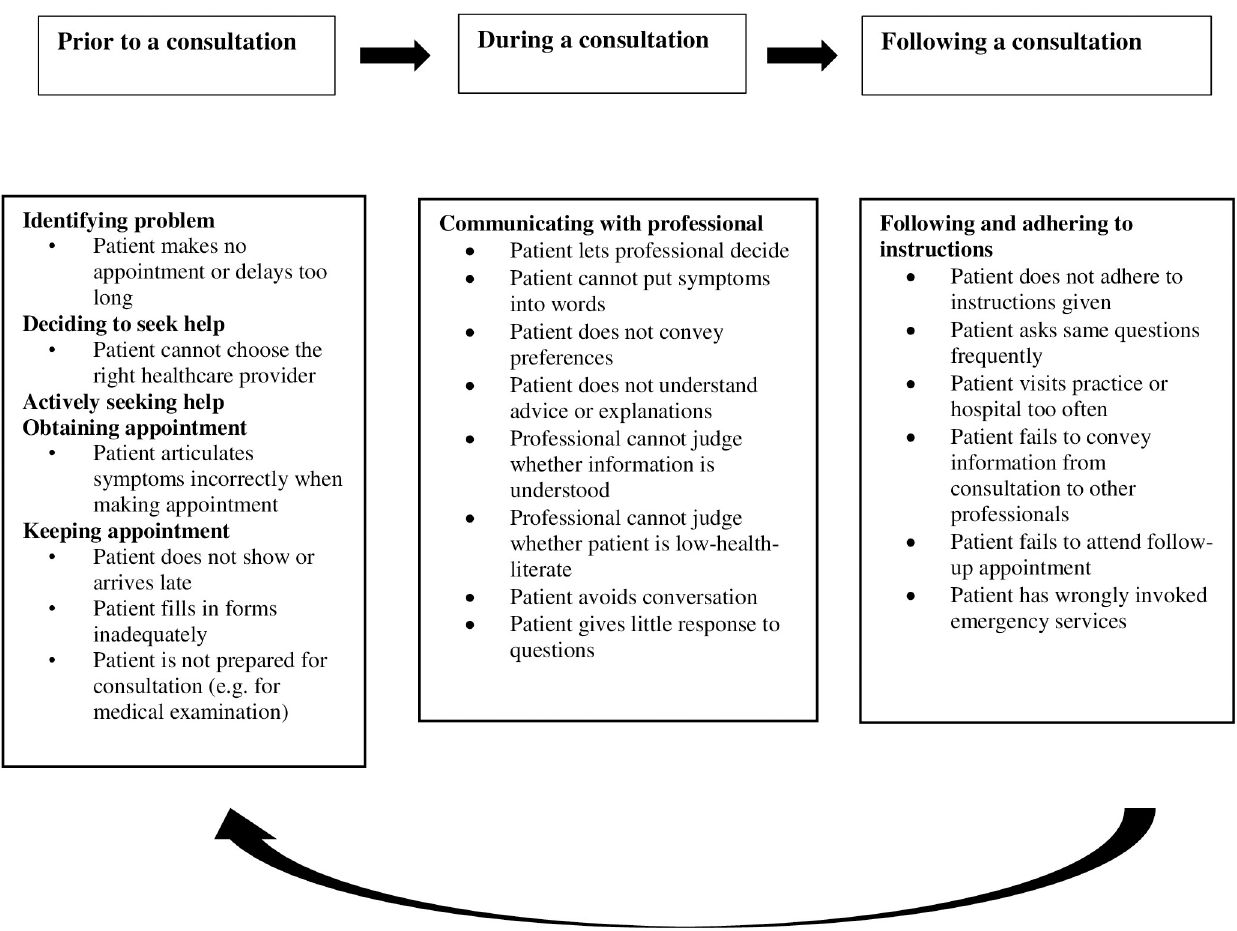
Fig 1. Healthcare journey in three stages with corresponding challenges � . � Conceptual framework adapted from literature